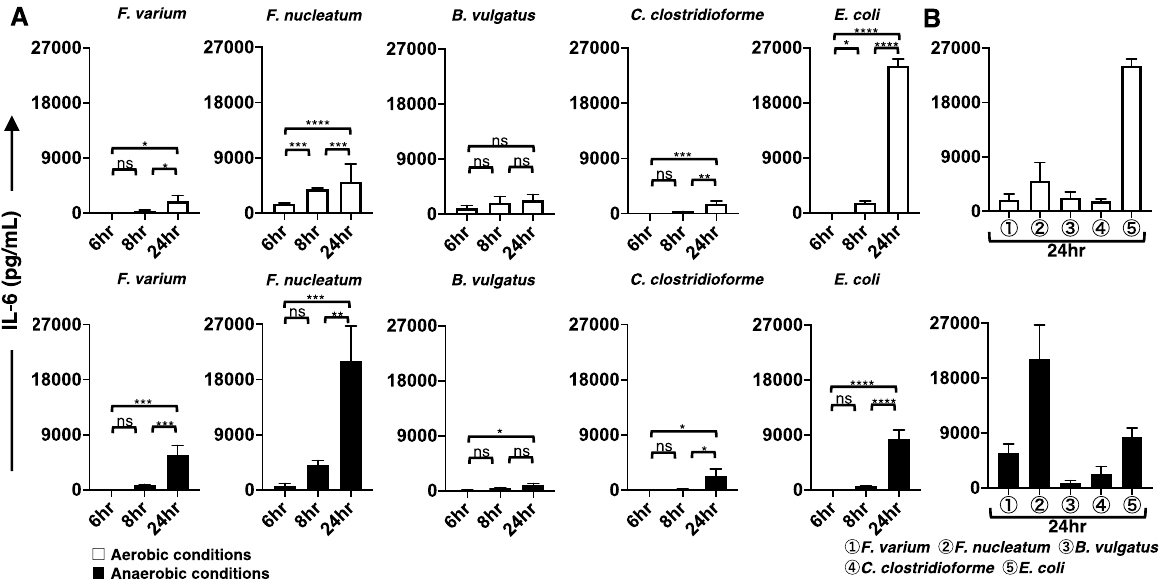
Figure 5. The production of IL-6 by the DC line stimulated with live commensal bacteria. ( A ) Under aerobic (upper panel, white bar) and anaerobic (lower panel, black bar) stimulation conditions, TNF-α production during the initial (total of 6 and 8 h) and late phases (total of 24 h) by the DC line after stimulation with six strains of live commensal bacteria. ( B ) Under aerobic (white bar) and anaerobic (black bar) conditions, IL-6 production during the late phase (total of 24 h) by the DC line after stimulation with six strains of live commensal bacteria was assessed. The six live commensal bacterial strains are as follows: Fusobacterium varium ( F. varium ), Fusobacterium nucleatum ( F. nucleatum ), Bacteroides vulgatus ( B. vulgatus ), Clostridium clostridioforme ( C. clostridioforme ), Escherichia coli ( E. coli ), and Lactobacillus delbrueckii subsp. bulgaricus ( L. bulgaricus ). The results are presented as the means ± SD from three independent experiments. Tukey’s multiple comparisons test was used to compare the levels of IL-6 after 6, 8, and 24 h of culture. ns; not